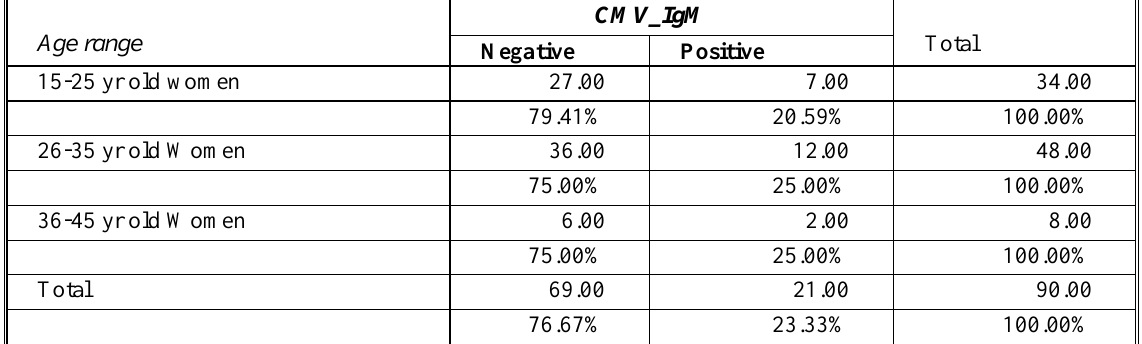
Table 3. Prevalence of CMV IgM among different age